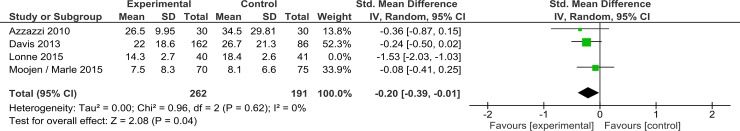
Comparison II (device versus decompressive surgery interventions), sensitivity analysis for the outcome of overall functional status without data from Lonne, showing high homogeneity.